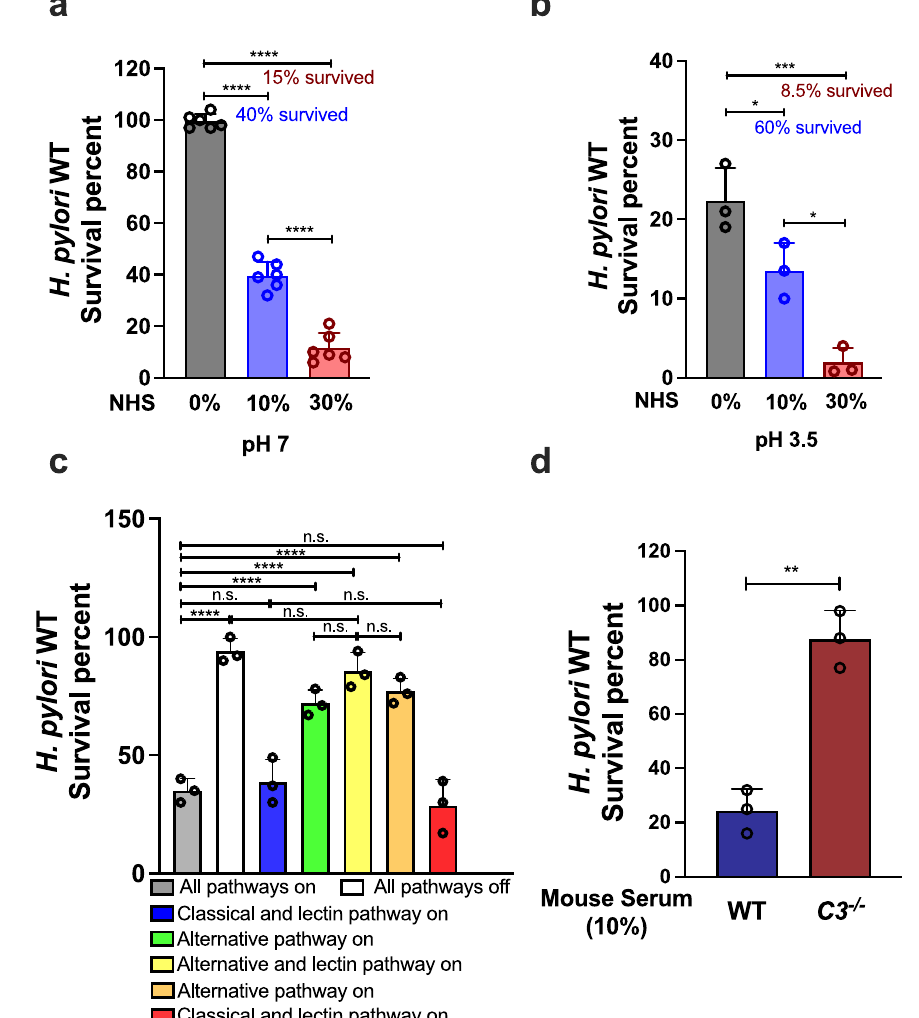
Fig. 2 | H. pylori is sensitive to complement-mediated elimination. Overnight culturesof H.pylori PMSS1WTweretreatedwithinactiveandactiveNHSormouse serumattheindicated fi nalpercentagesfor1h,andthenviablebacterialCFUswere determined by plating. The survival percent was determined by comparing the number of CFUs from active serum divided by the total CFUs, obtained from heat- inactivatedserumtreatment. a Comparisonofdifferent fi nalpercentagesofNHSat pH of 7. b Comparison of different fi nal percentages of NHS at pH of 3.5. Survival ratio without NHS treatment was acquired by comparing the bacterial number at the end time point to the input number. c H. pylori cultures were treated by untreated NHS (gray bar, all pathways on); EGTA-conditioned NHS to block all complementpathways(whitebar,allpathwaysoff);EGTA+Ca 2+ (bluebar,classical and lectin pathway on); EGTA+Mg 2+ (green bar, alternative pathway on); C1q-